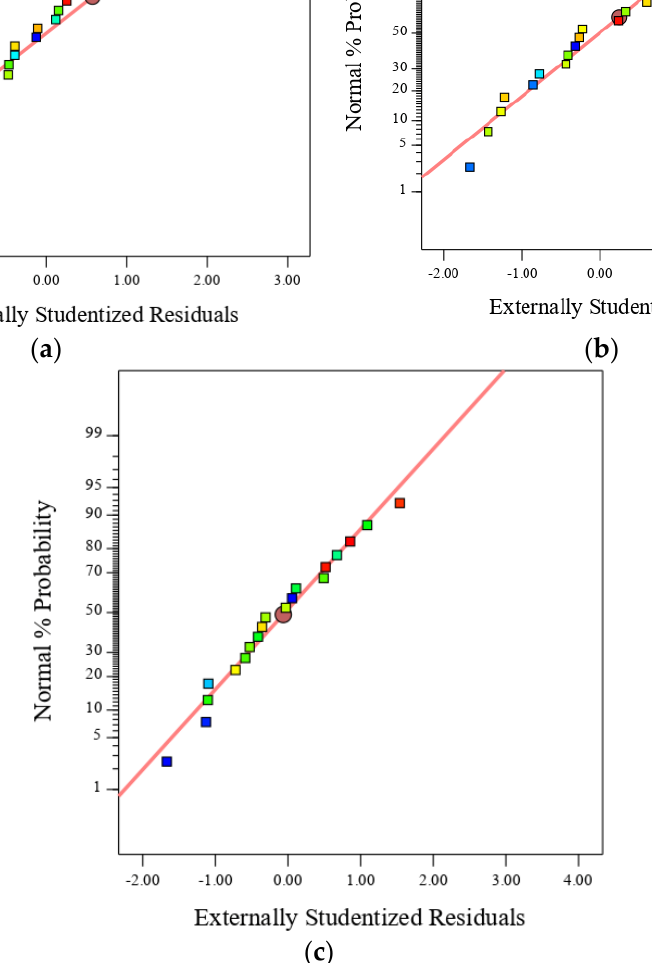
Figure 4. Normal probability plots of ( a ) compressive strength, ( b ) flexural strength, and ( c ) tensile strength.